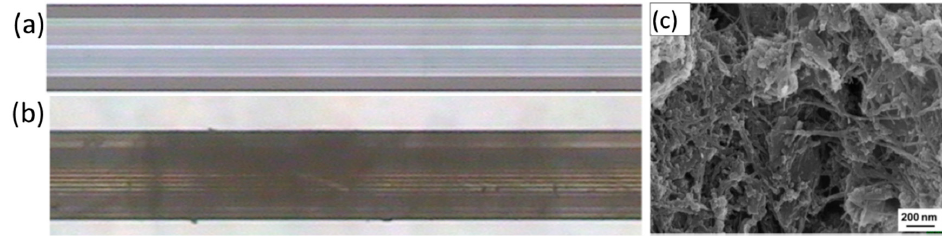
Figure 26. Images from an optical microscope ( a ) of the PCF before and ( b ) after the CNT deposition; ( c ) SEM capture of the CNT doped with copper nanoparticles coat deposited on optical fibre. Reprinted from [130,131] with the permission of Elsevier.